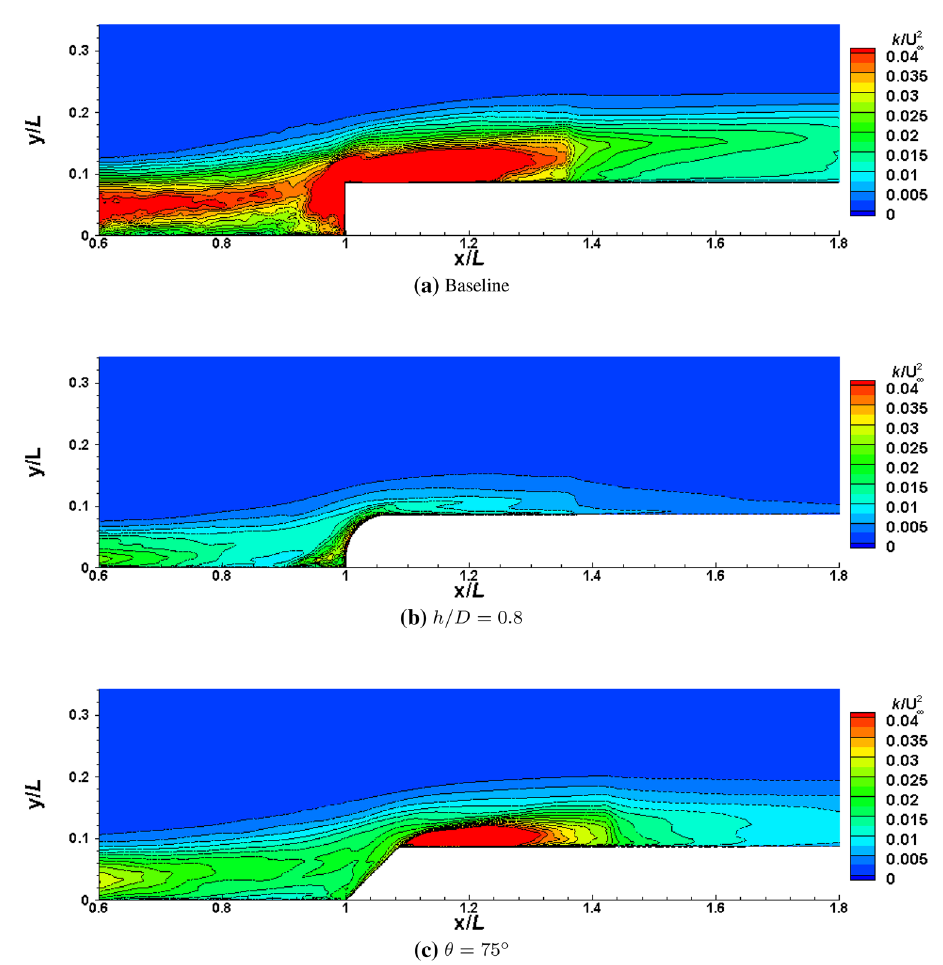
Fig. 8 Comparison of turbulence kinetic energy for the baseline ( a ), h = D ¼ 0 : 8 ( b ) and h ¼ 75 (cid:8) ( c ) in the cavity trailing edge region